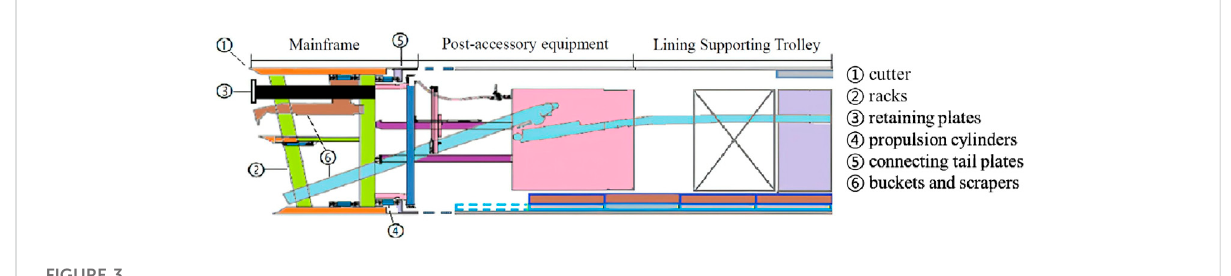
FIGURE 3 Structure of a slotted